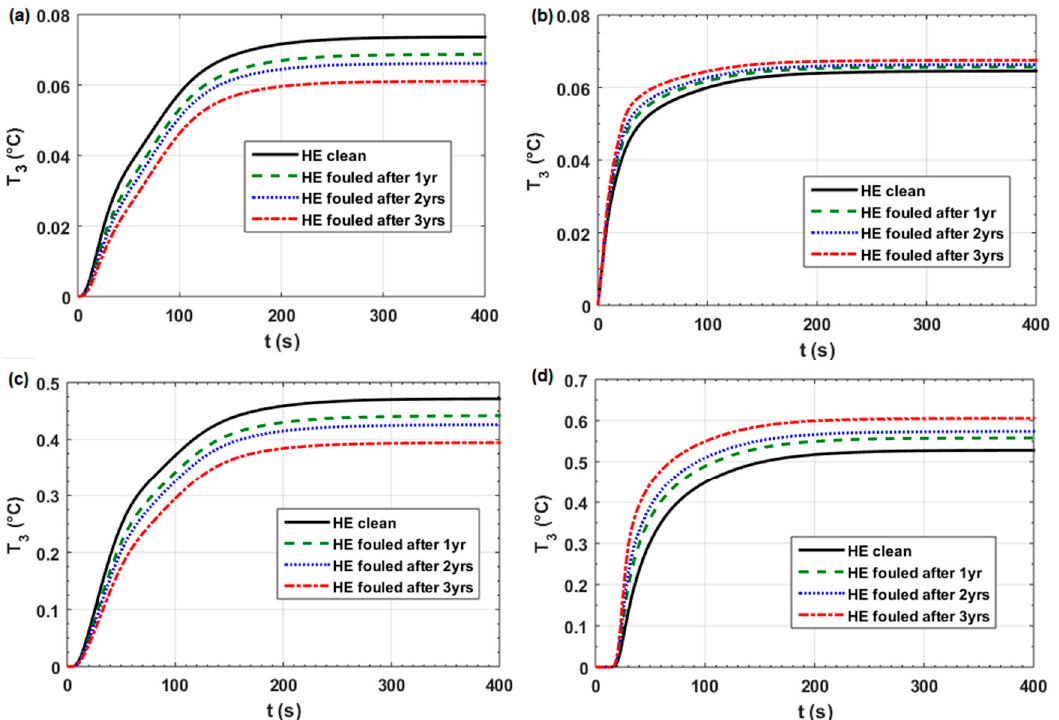
Figure 15. Open-loop step responses under fouling conditions of the outlet temperature T 3 of E3-18AB exchanger: ( a ) on a +1% step change in the shell-side flowrate, ( b ) on a − 1% step change in the tube-side flowrate, ( c ) on a +1 ◦ C step change in the shell-side inlet temperature and ( d ) on a +1 ◦ C step change in the tube-side inlet temperature.